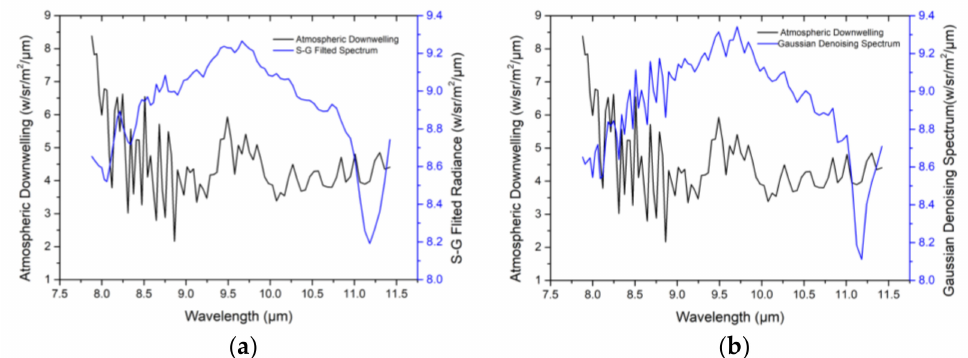
Figure 9. Comparison between spectral and spatial denoising for Hyper-Cam LW hyperspectral im- agery: ( a ) comparison between S–G-filtered image radiance and atmospheric downwelling; ( b ) com- parison between Gaussian spatial denoising result and atmospheric downwelling.